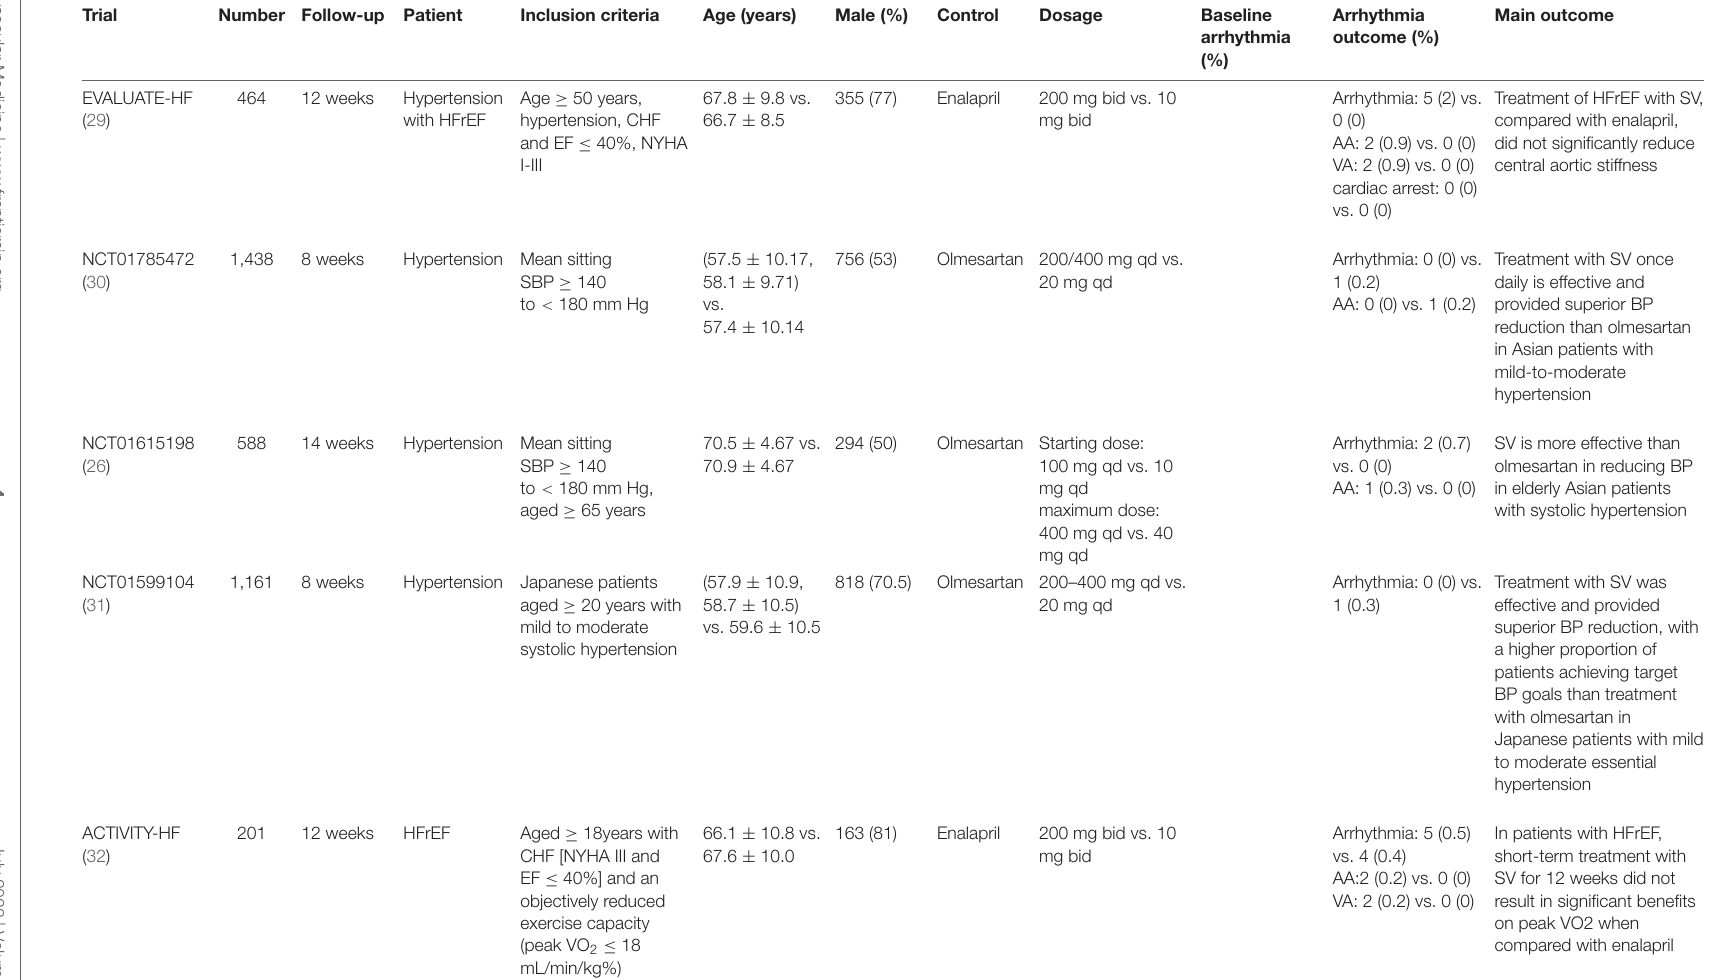
TABLE 1 | Characteristics of included